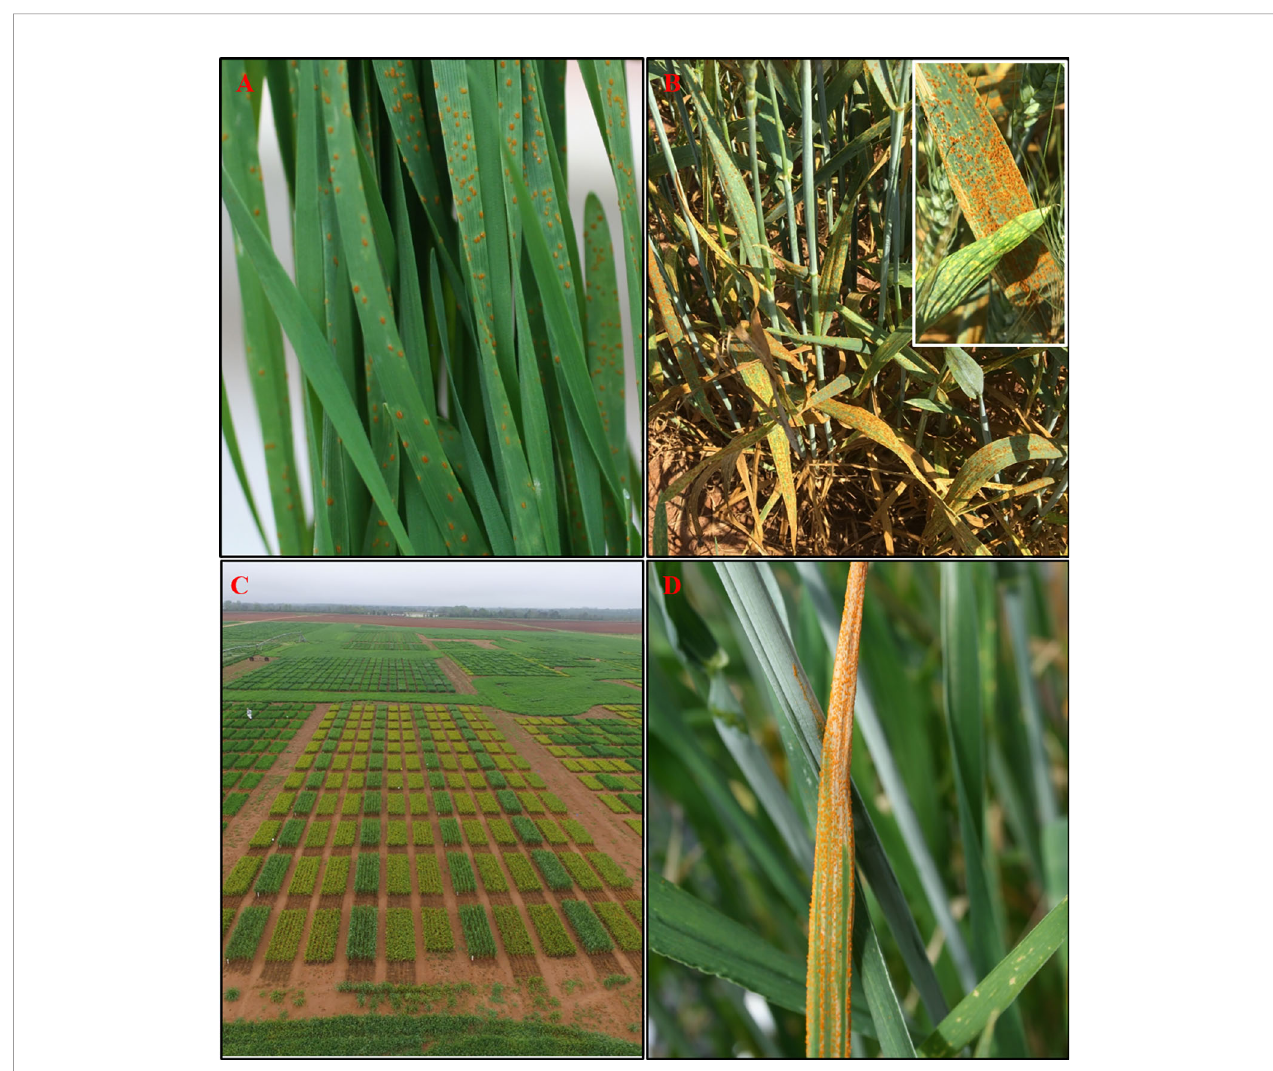
FIGURE 2 | Wheat rusts; leaf rust (LR) uredinia on wheat seedlings in greenhouse (A) , and adult plants in the fi eld (B) used to assess seedling and adult plant resistance, respectively, stripe rust (SR) disease in the fi eld plot compared to healthy wheat (C) , and SR uredinia showing the elongated stripes typical of the disease on the fl ag leaf of adult plants in the fi eld (B) . Field photos are taken from southwest Georgia research and education center, Plains, GA (Source: Figures 2A, B, S. Sapkota; 2C, D , A. D.